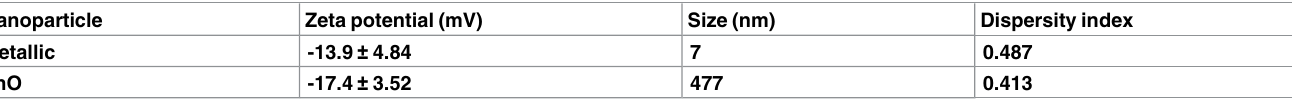
Table 1. Characterization of the